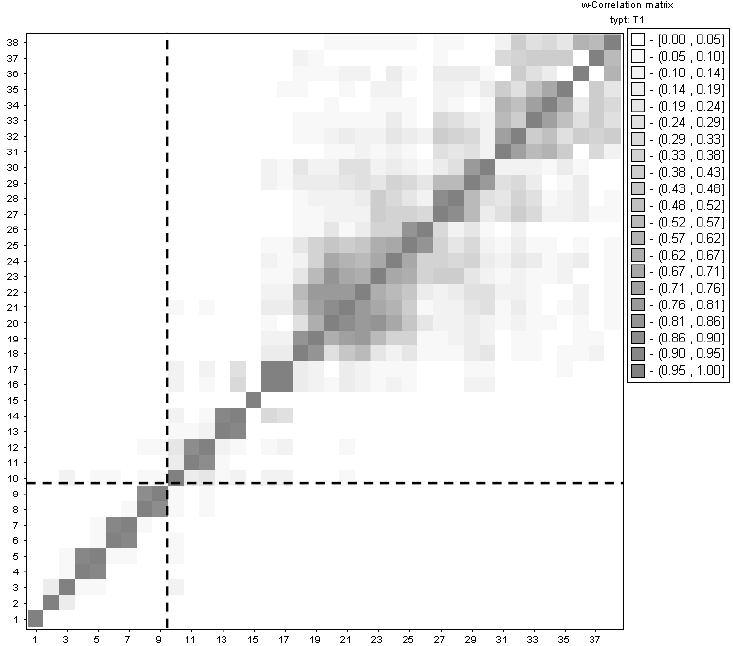
Figure 8. Matrix of w-correlations for the 38 reconstructed components.